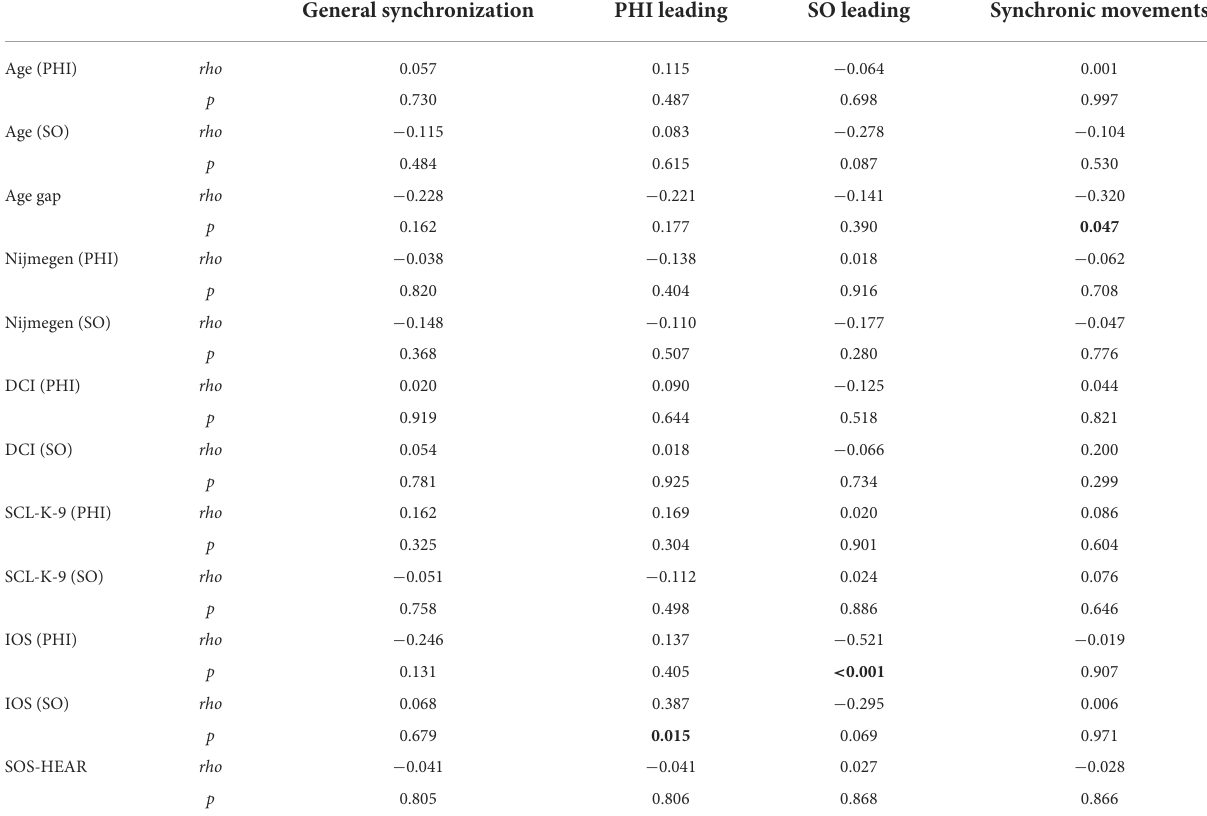
TABLE 3 Correlation nonverbal synchrony with age, age gap, and questionnaires ( N = 39). General synchronization PHI leading SO leading Synchronic movements